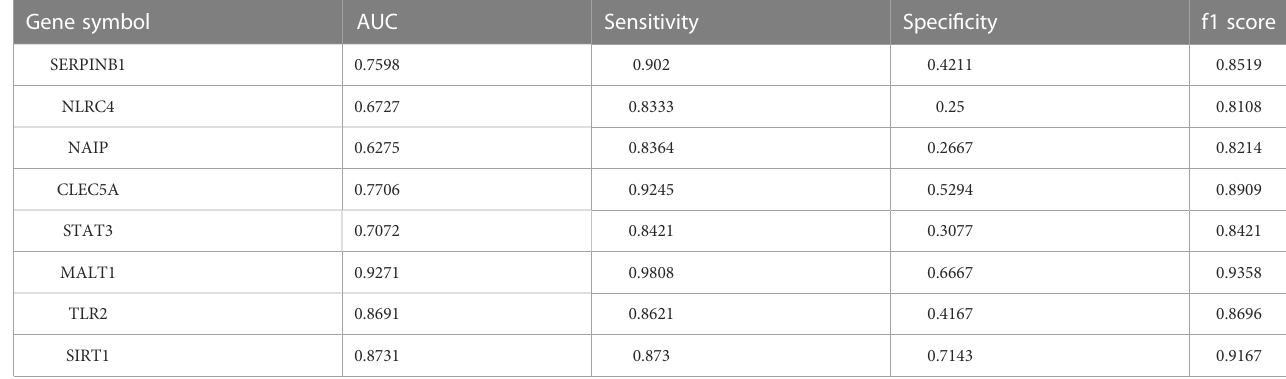
TABLE 3 AUC, sensitivity, speci fi city, and f1 score of the diagnostic model composed of a single gene on the external test set. Gene symbol